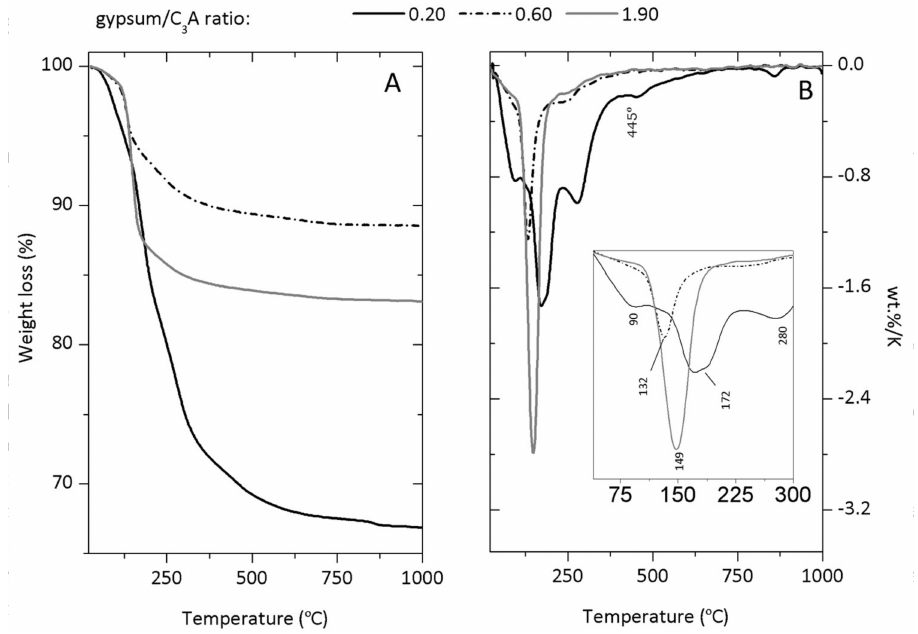
Figure A2. Weight loss curve profiles determined by ( A ) TGA and ( B ) DTG of the effect of different gypsum contents on cubic C 3 A